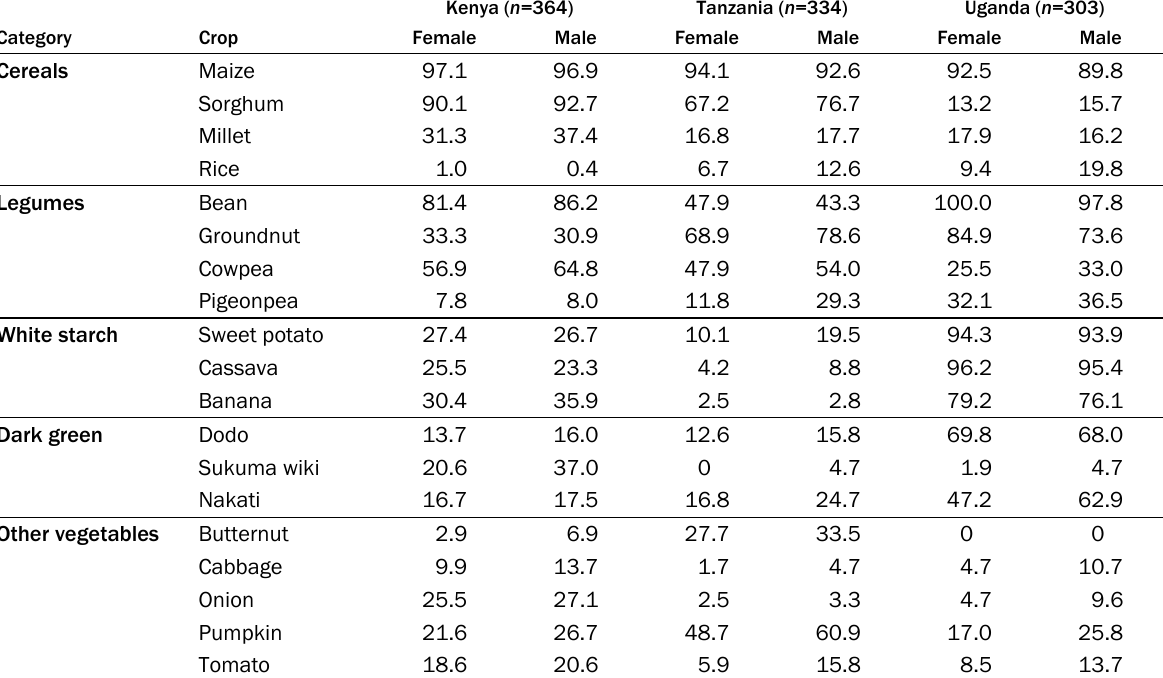
Table 4. Food Crops Grown, Percent of Households by Country and Gender of the Household Head Kenya ( n= 364) Category Crop Female Cereals Maize